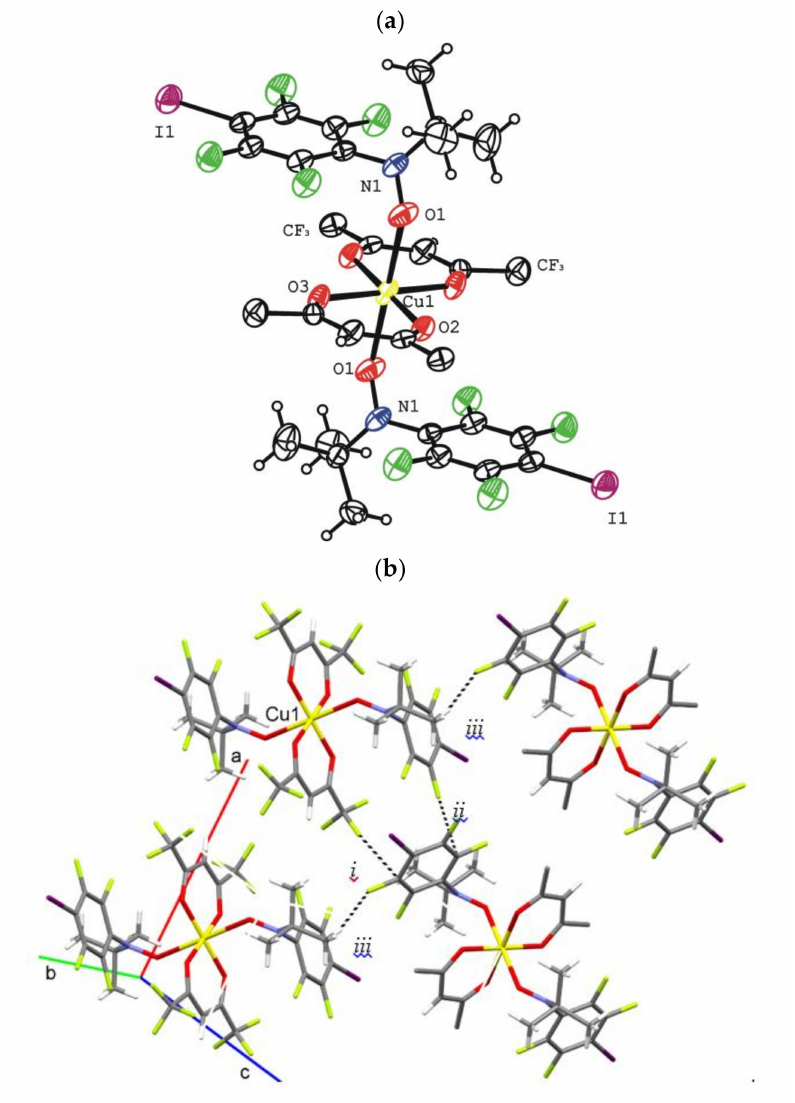
Figure 5. Molecular structure (( a ) one of the independent molecules) and fragments of crystal structure ( b ) of the [Cu(hfac) 2 ( 4 ) 2 ] complex (the thermal ellipsoids are drawn at the 30% probability